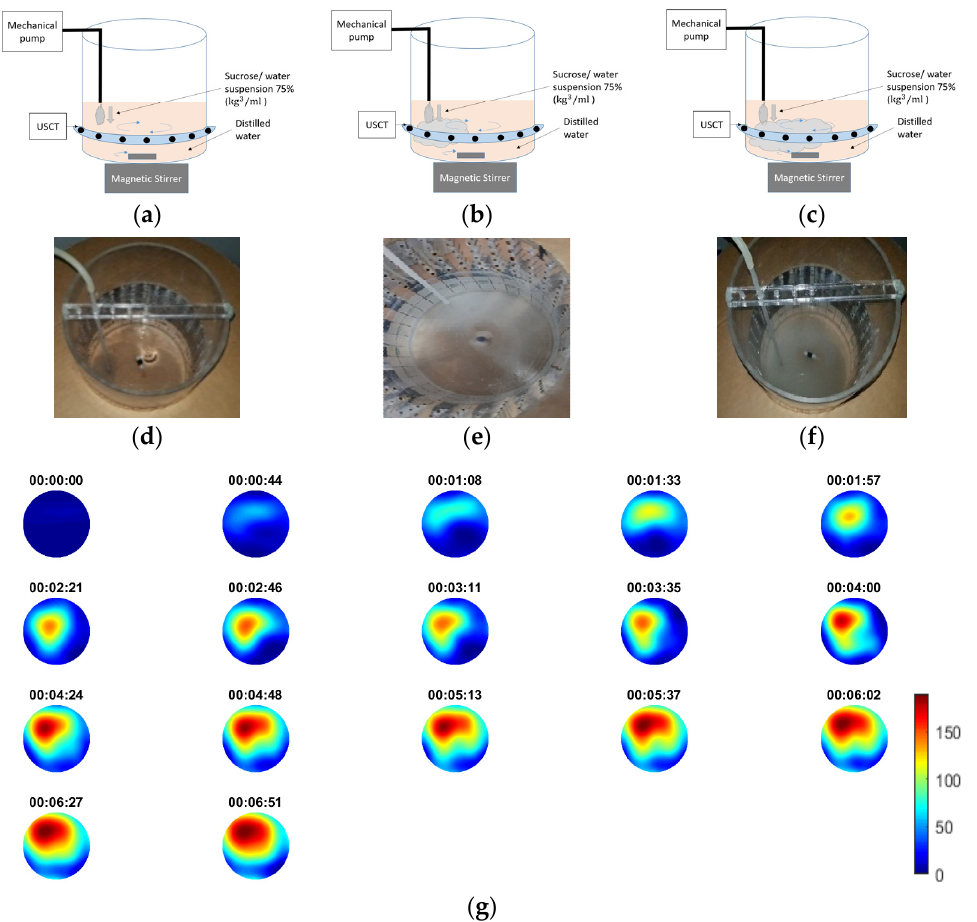
Figure 6. ( a – c ) Schematic of the experiment with corresponding photos. ( d – f ) Experimental photos of the start, the middle and the end of the process, respectively. ( g ) Reconstruction with the specific capture time. Scale bar describes pulses’ travel-time delays.